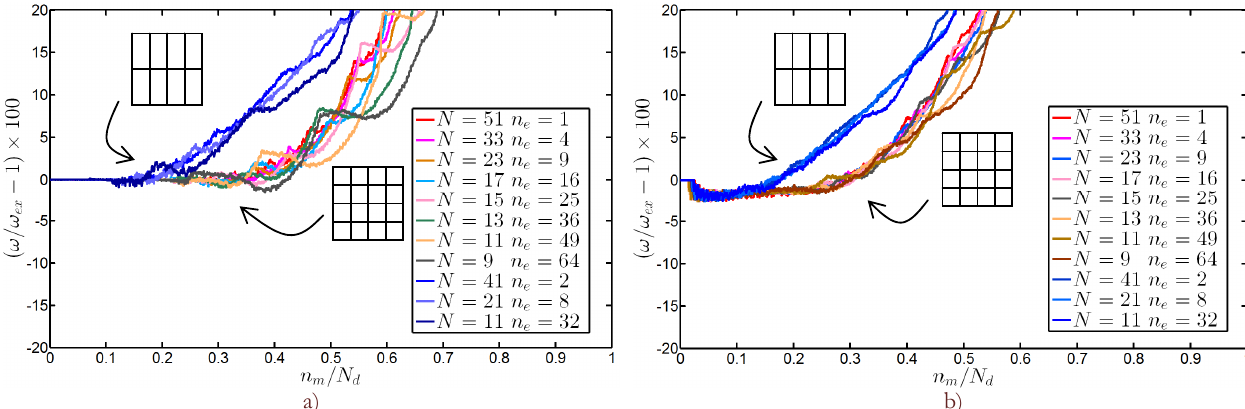
Figure 8: a) Dynamic discrete spectra using different meshes (structured and distorted) of a Membrane using PDQ basis functions and Leg-Gau grid distribution. b) Dynamic discrete spectra using different meshes (structured and distorted) of a RM plate using PDQ basis functions and Leg-Gau grid